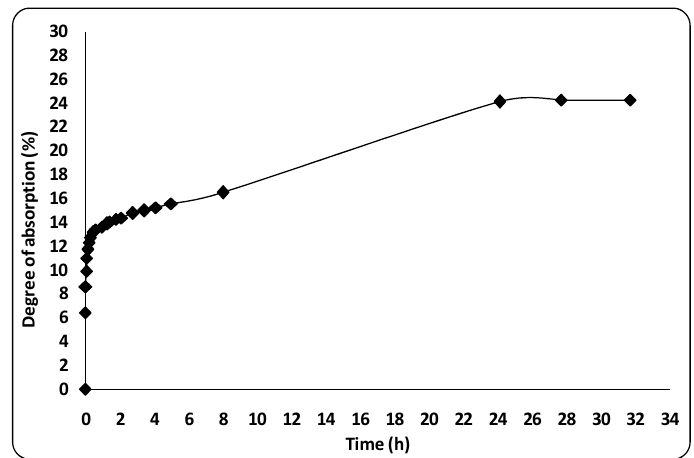
Figure 11. Specimen absorption degree as a function of time.